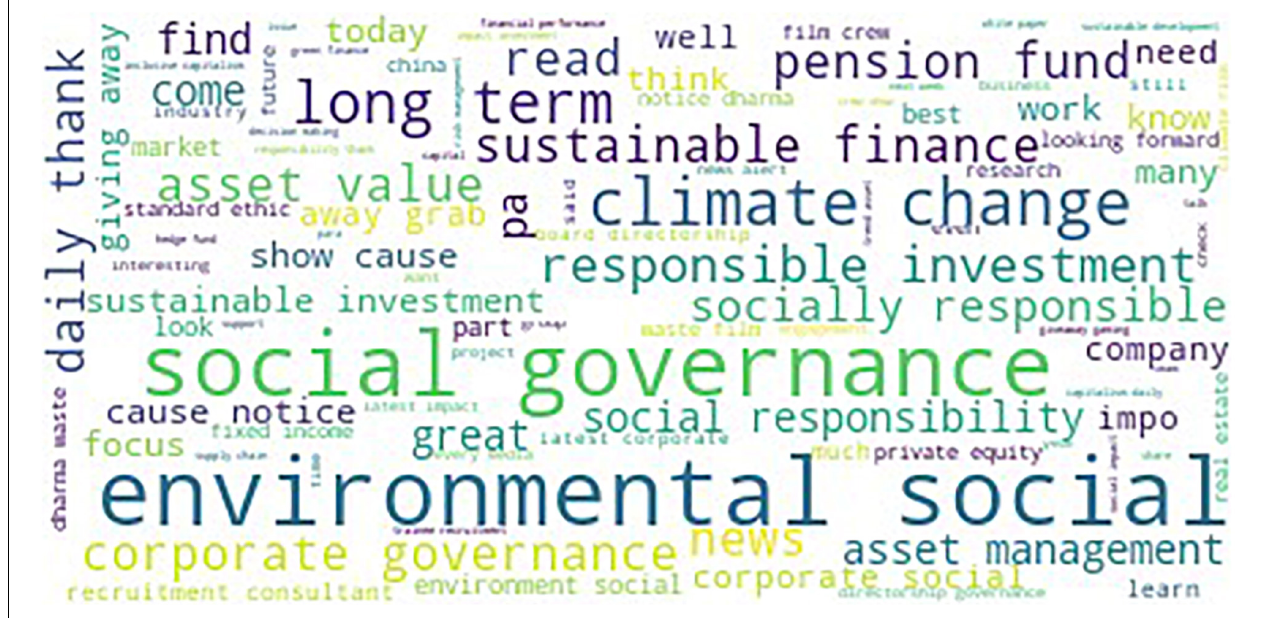
FIGURE 5 | Word cloud of the most common cleaned words after